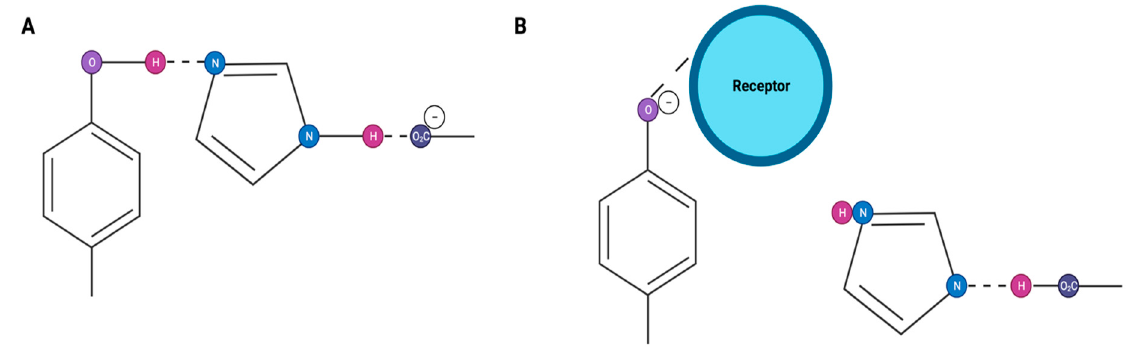
Figure 1. Angiotensin CRS showing the movement of charge from carboxylate to tyrosinate ( A ); interaction of tyrosinate with receptor ( B ).